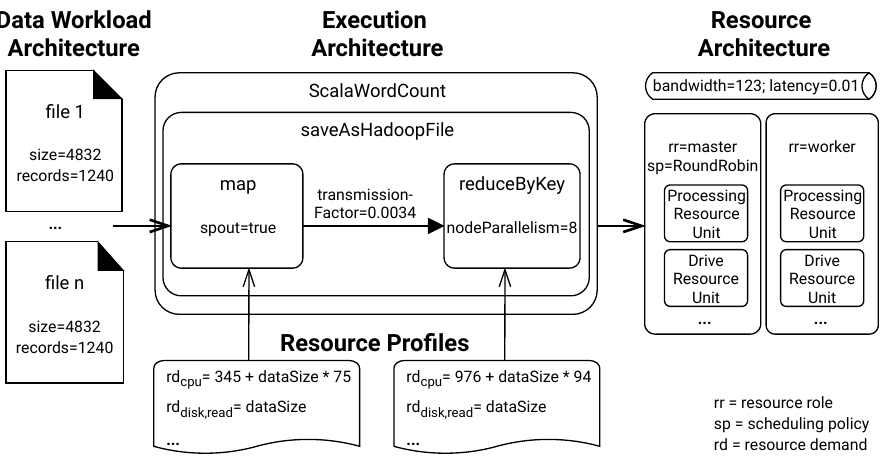
Figure 2. Exemplary PerTract-DSL